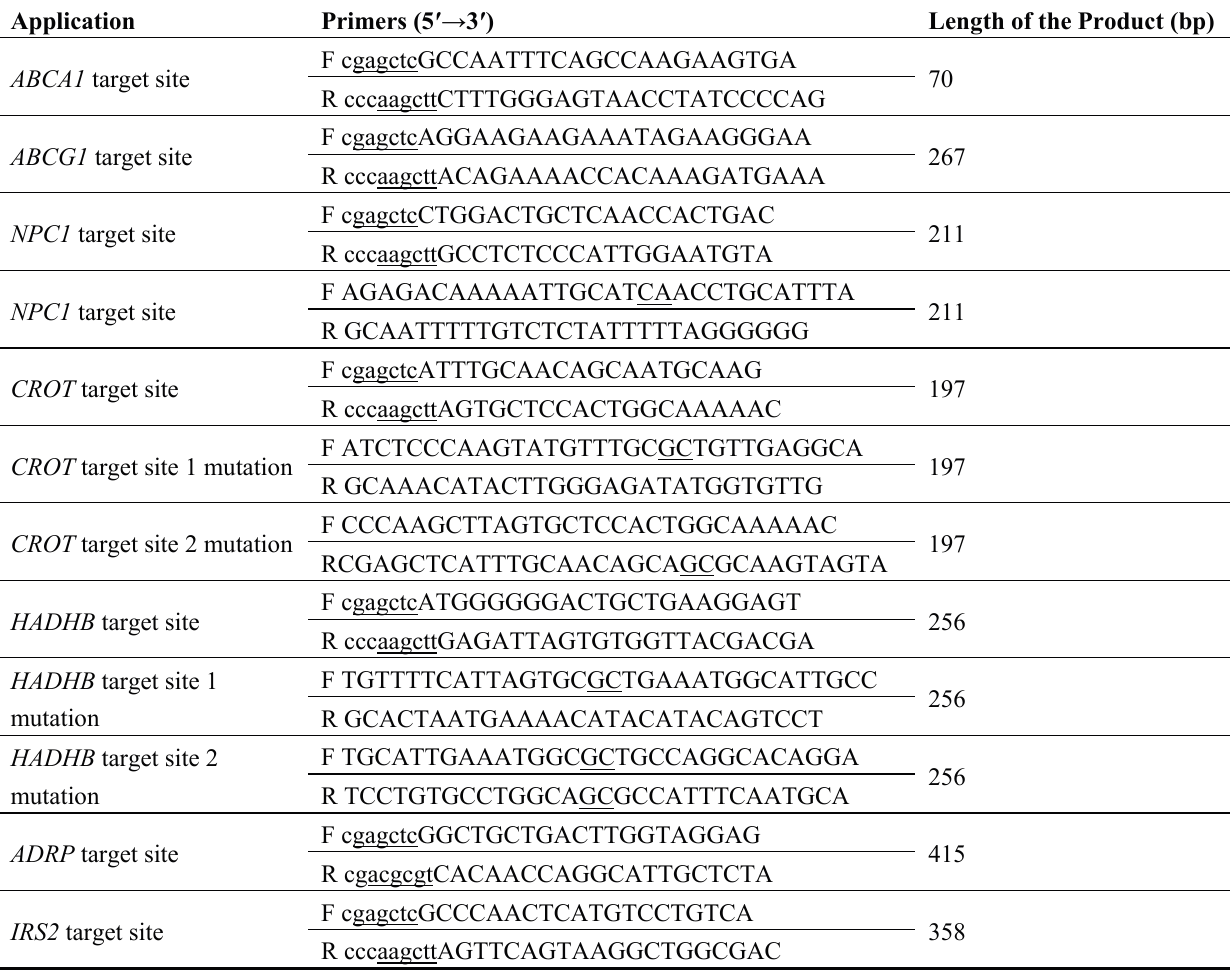
Table 1. Primers for carrier